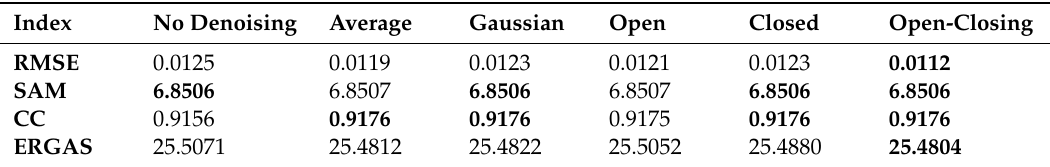
Table 2. Performance of the HFWT method with di ff erent HS image denoising processing. (The best values of each index are marked in